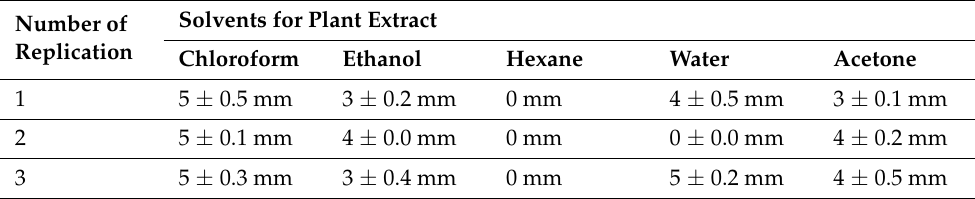
Table 2. Average zone of inhibition for sunflower seed in five different solvents. Number of Replication